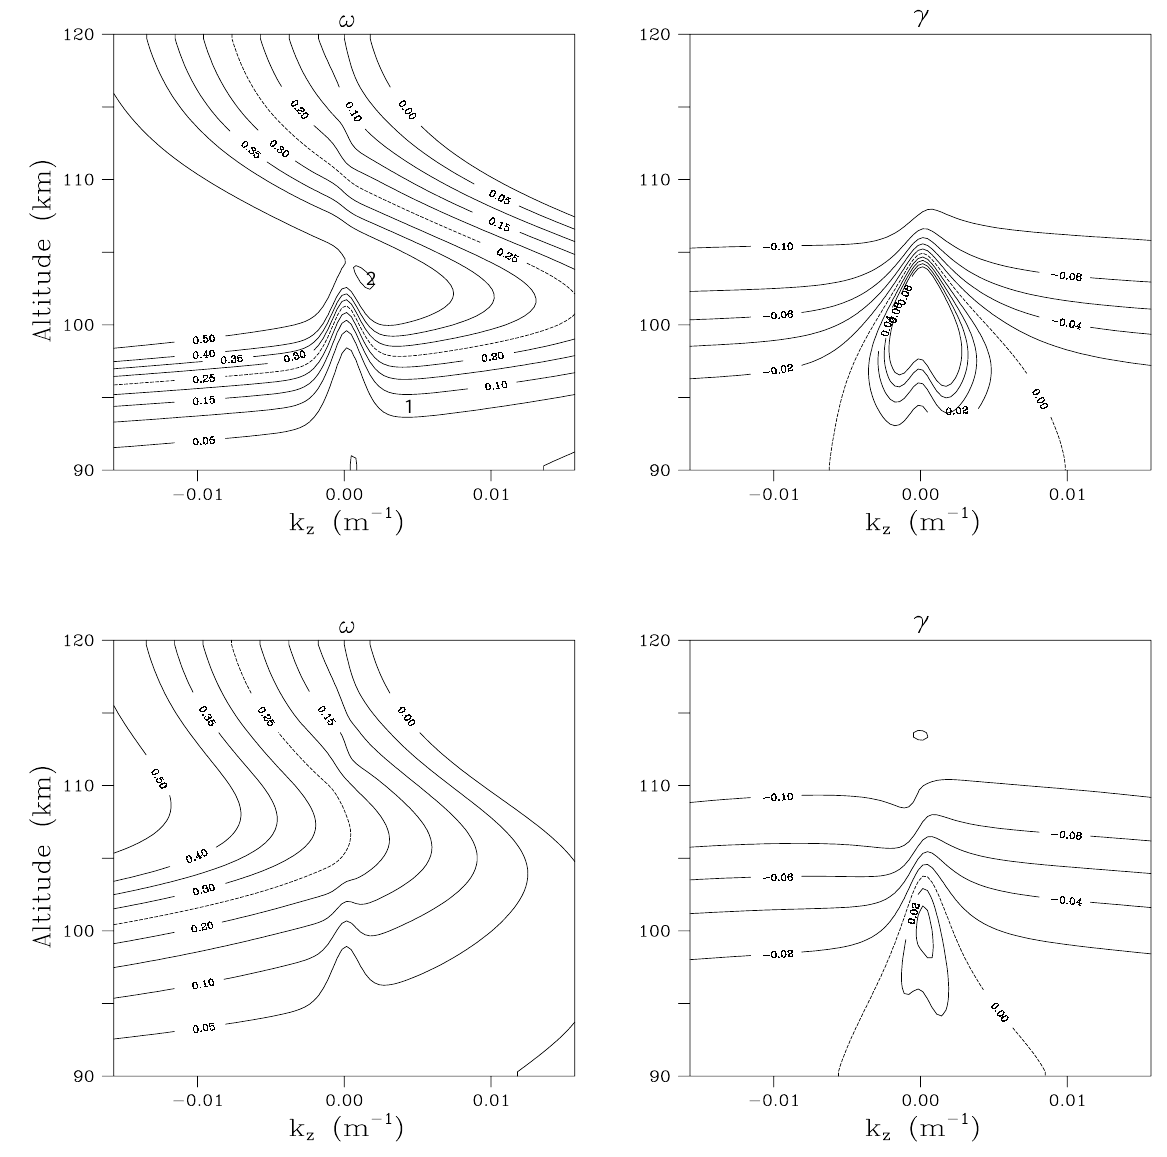
Fig. 5. Contours of constant frequency and growth rate derived from the local dispersion relation described in the Appendix for k x =1 × 10 − 3 m − 1 , plotted in the k z − z plane. (Top) Daytime case with no anomalous electron mobility. (Bottom) Daytime case with anomalous electron mobility. The zonal electric field for both cases was taken to be 0.65mV/m. Model atmospheric and ionospheric pa- rameters were derived from the International Reference Ionosphere (IRI) and Mass Spectrometer Incoherent Scatter (MSIS) models (Bilitza et al., 1993; Hedin et al., 1996). Collision frequencies were derived according to expression from Richmond (1972) and Gagnepain et al. (1977) and reproduced by Forbes (1981) in his Eqs.